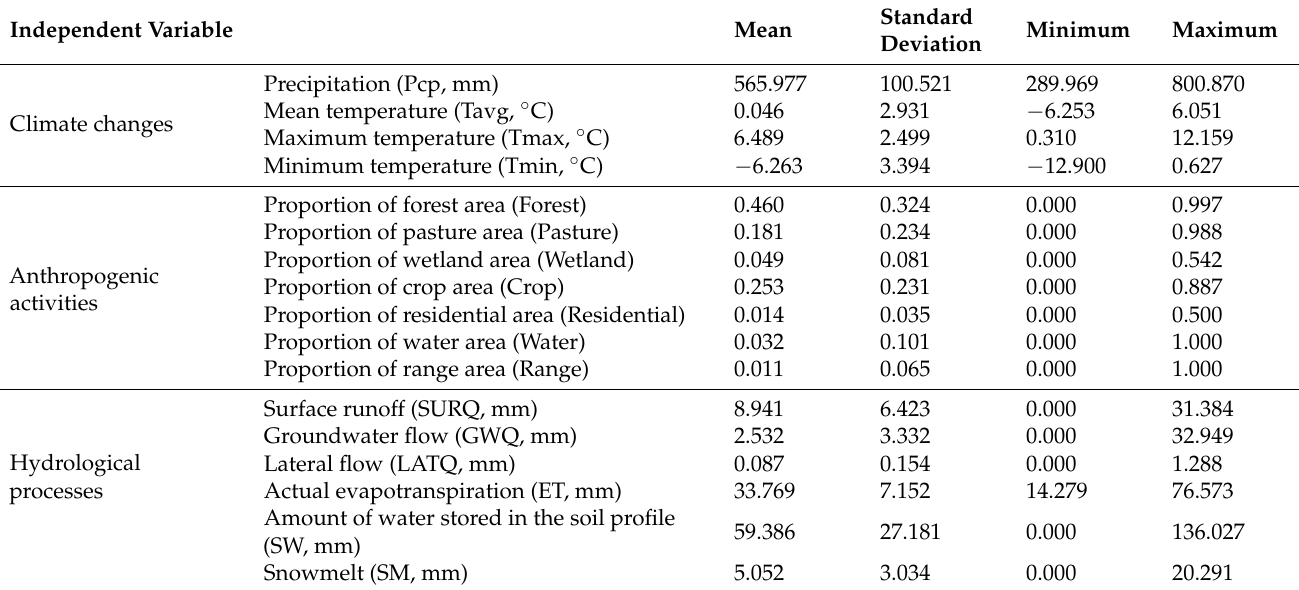
Table 3. Statistical results of period-average explanatory variables for four periods at the sub-basin scale. Independent Variable